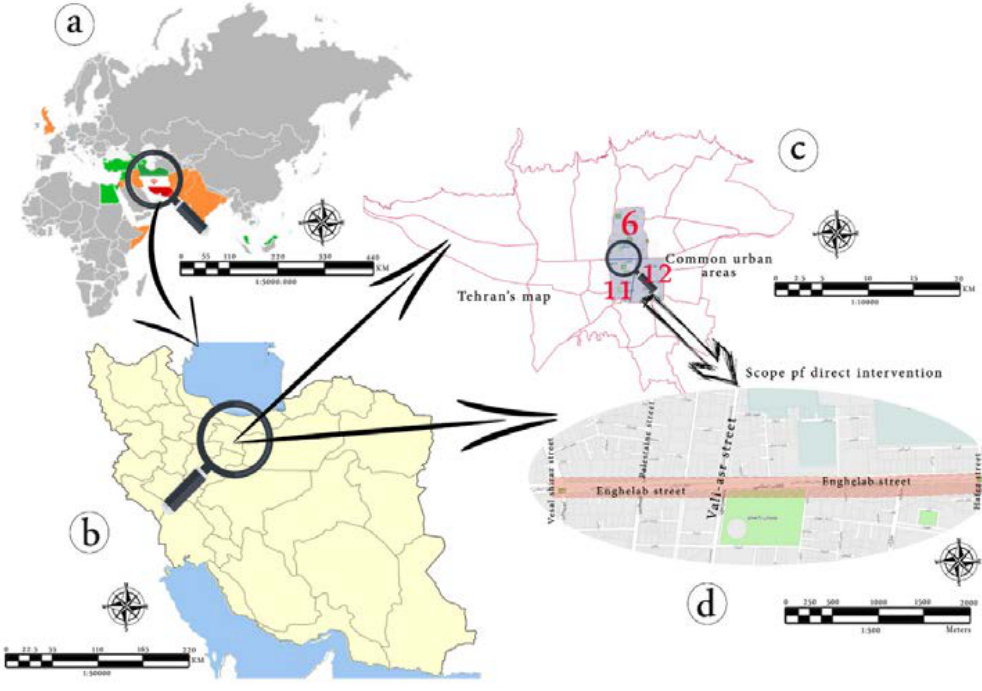
Fig. 4: Location of the scope of direct intervention in Tehran Fig . 4: Location of the scope of direct intervention in